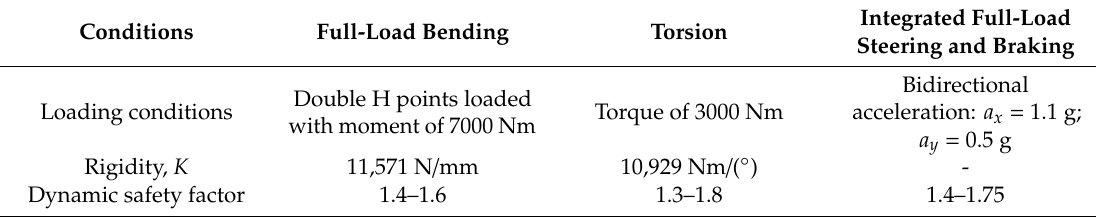
Table 8. Specific loadingmode and sti ff ness measurement results.